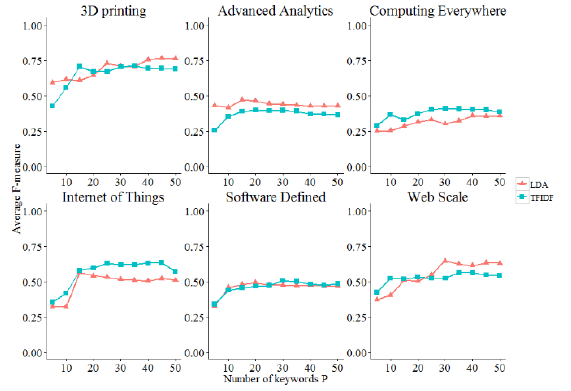
Fig. 7. Comparison of Keyword Extraction Model - Average Recall in each category across the number of keywords (red: LDA, blue: TFIDF)